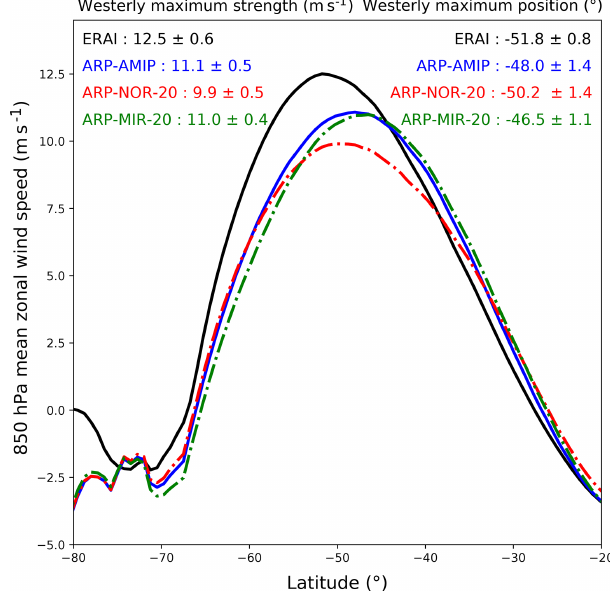
Figure 3. Mean latitudinal profile of 850hPa eastwards wind com- ponent (reference period: 1981–2010) for ARP-AMIP (grey), ARP– MIR-20 (dashed green), ARP–NOR-20 (dashed red) and ERA- Interim (black). Yearly mean ± 1 standard deviation of strength (ms − 1 , upper left) and latitude position ( ◦ , upper right) of the 850hPa westerly wind maximum.